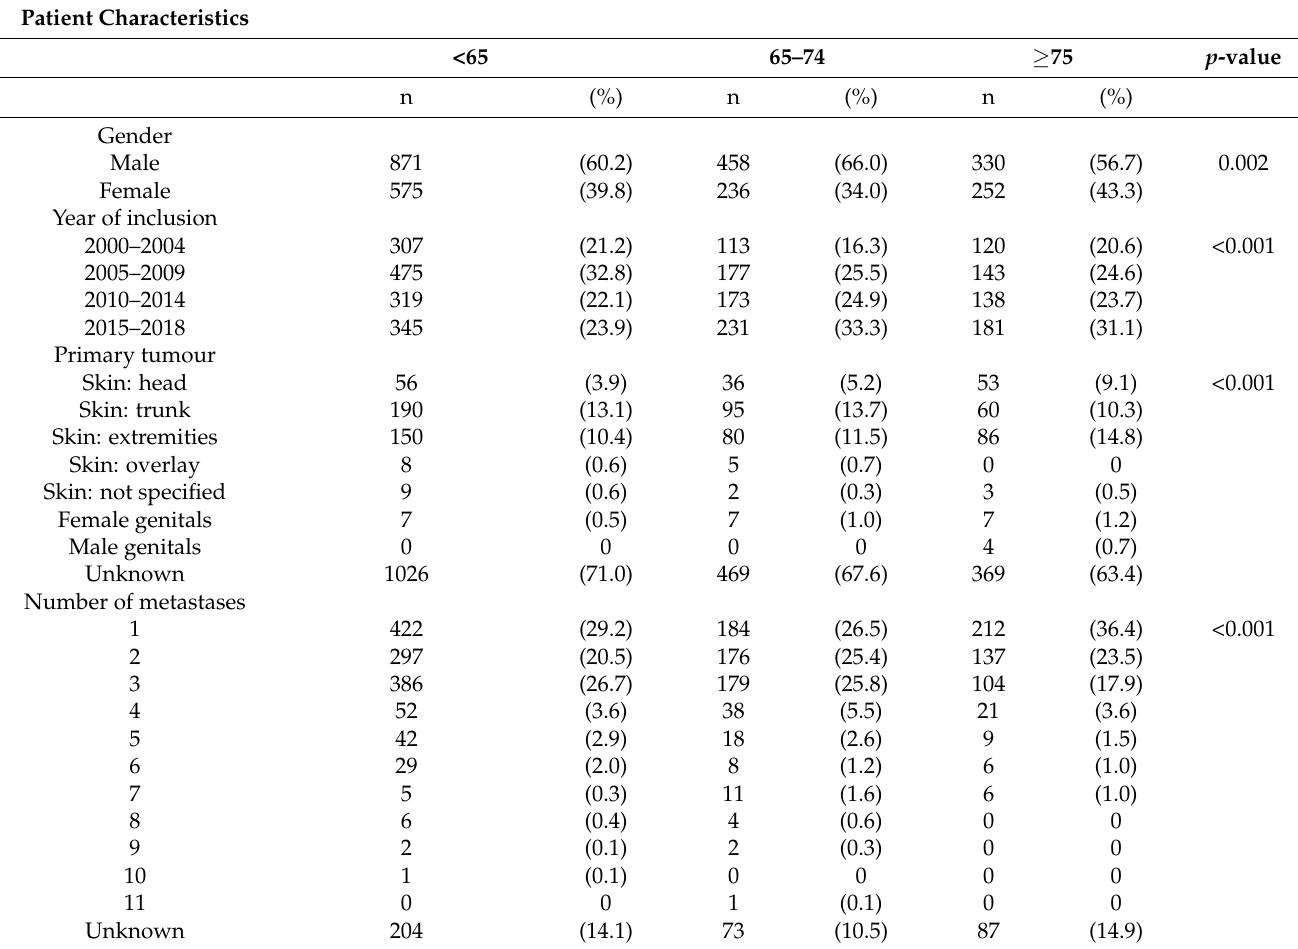
Table 1. Patient, tumour, and treatment characteristics by age (<65 vs. 65–74 vs. ≥ 75). Patient